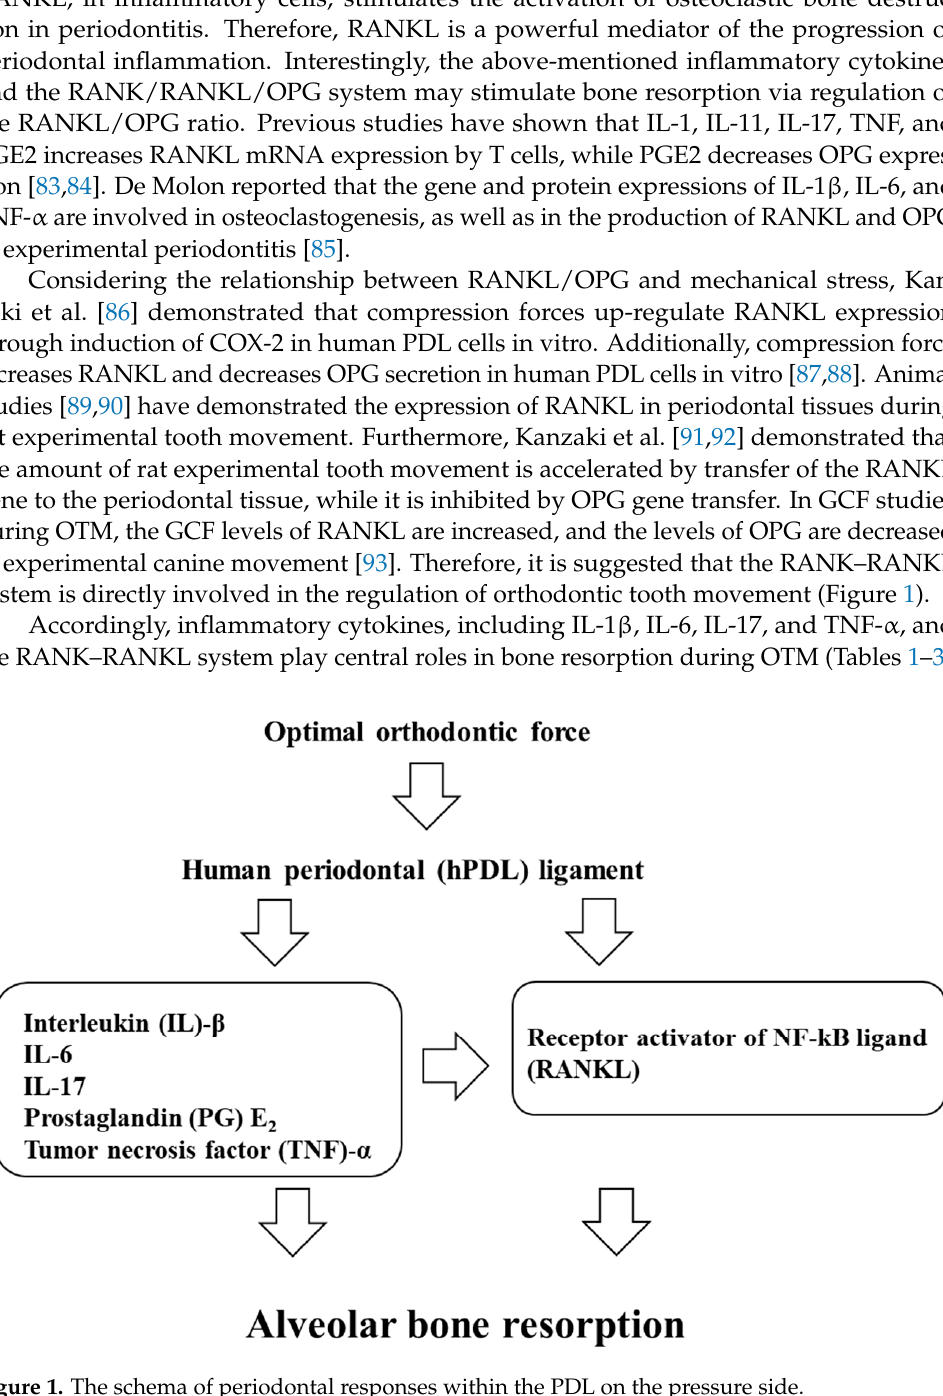
Figure 1. The schema of periodontal responses within the PDL on the pressure